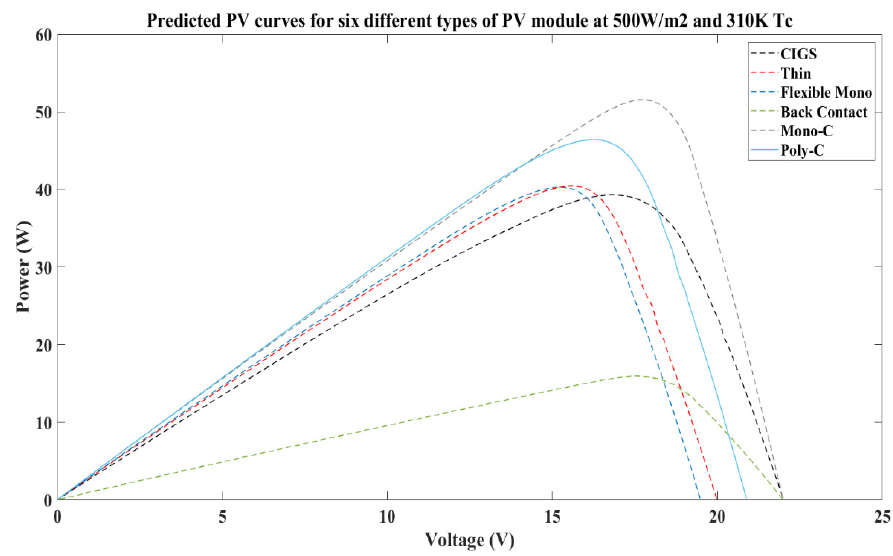
Figure 16. Predicted PV curves for the six PV modules at 500 W/m 2 and 310K Tc.